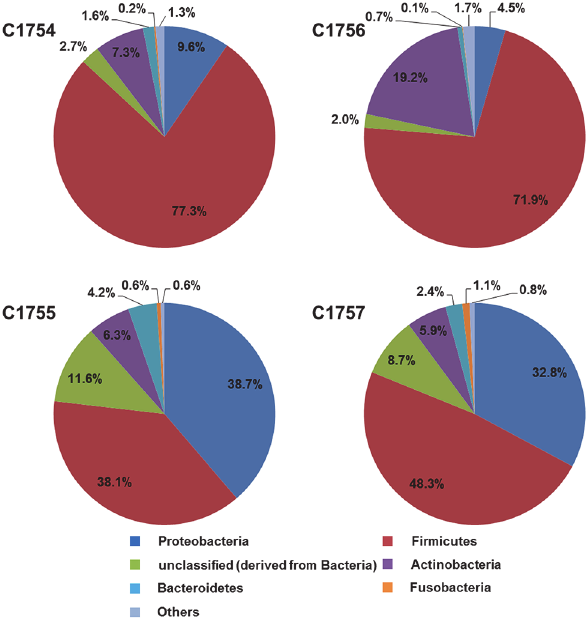
Fig 1. Phylogenetic compositions of the bacteria domain in the